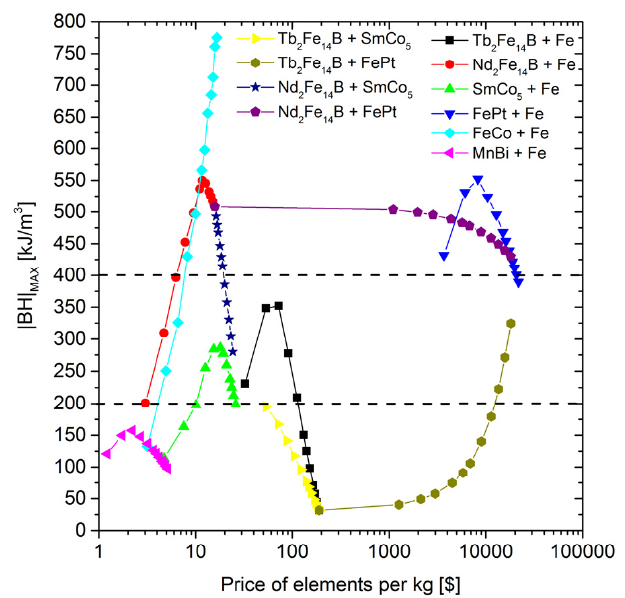
Figure 12. The | BH | max parameter as a function of the estimated price of the elements.